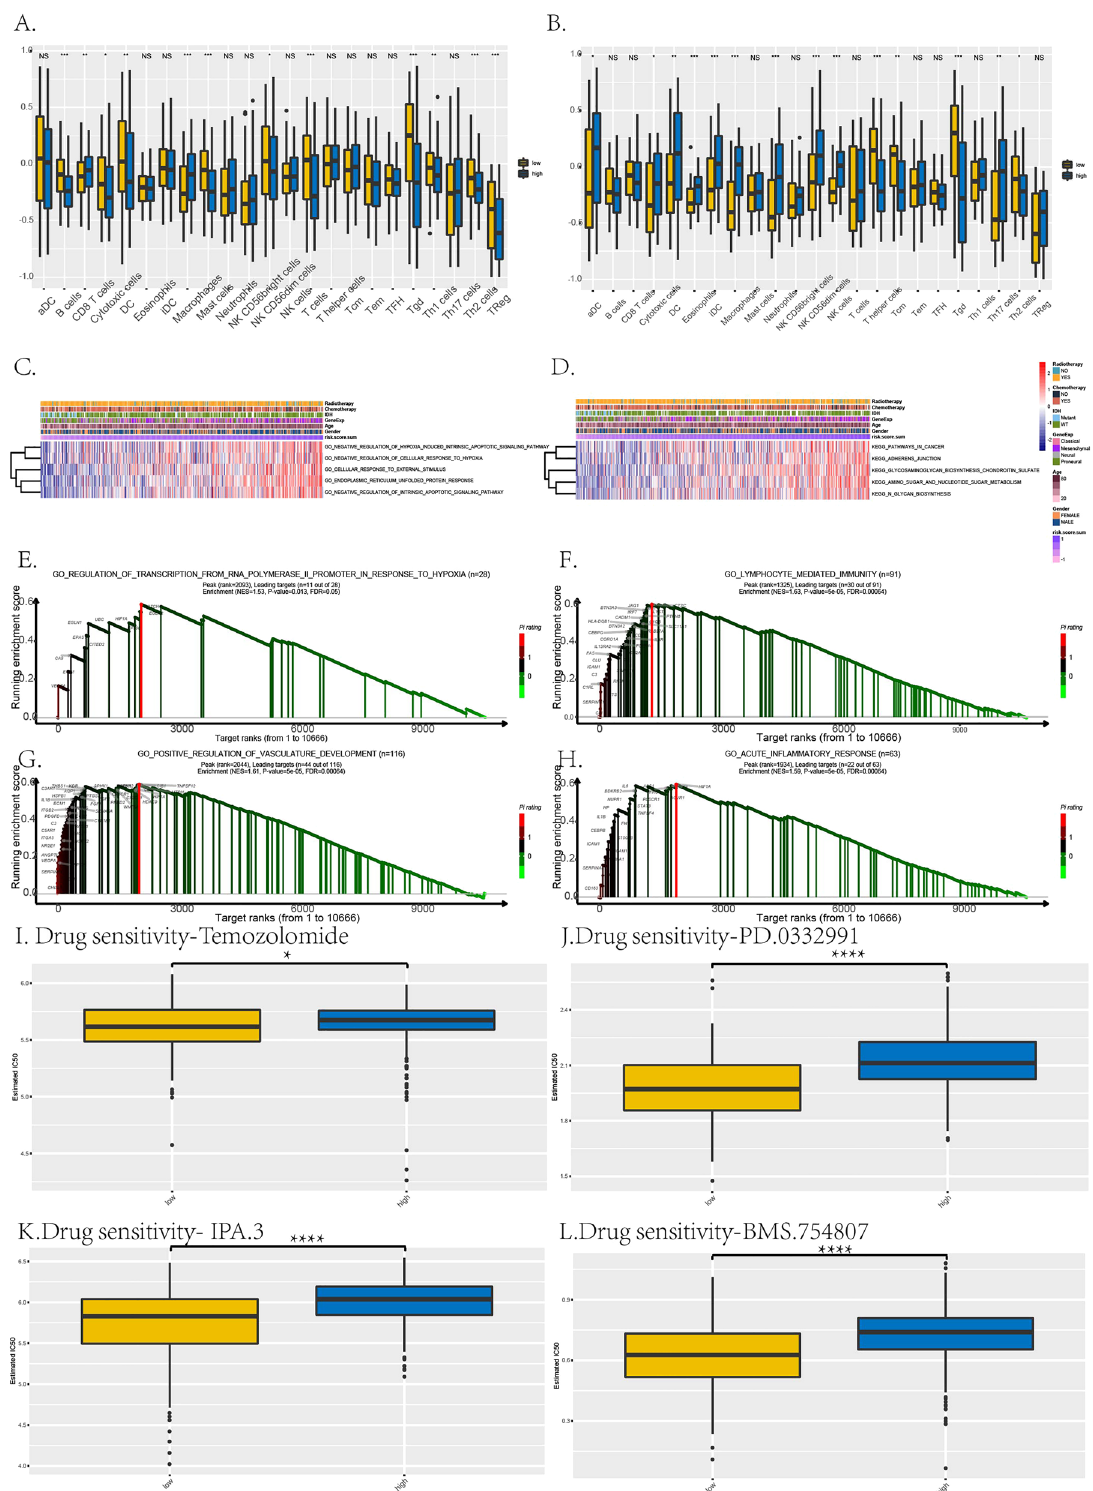
Figure 6. Immune infiltration, GSVA, GSEA analyses and prediction of chemotherapeutic response of the prognostic risk score model. ( A , B ) Immune cells expressed levels between high- and low-risk groups in TCGA ( A ) and CGGA ( B ). ( C , D ) The GSVA analysis in TCGA ( C ) and CGGA ( D ). ( E , H ) The GSEA analysis in TCGA. ( I – L) Drug sensitivity of this risk score model, temozolomide, PD.0332991, IPA.3, and BMS.754807 as representatives. * p < 0.05; **** p <